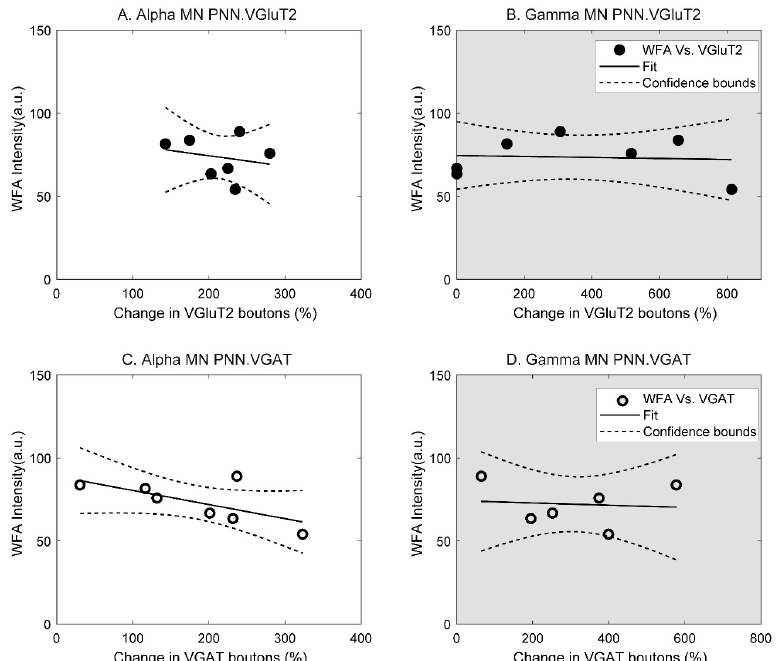
Figure 5. In α -MNs, a negative correlation between WFA intensity and percent change in synaptic boutons develops after 67 days post-injury for VGluT2 ( A ) and VGAT ( C ). In γ -MNs, no relationship between WFA intensity and changes in synaptic boutons was observed for either VGluT2 ( B ) or VGAT ( D ).